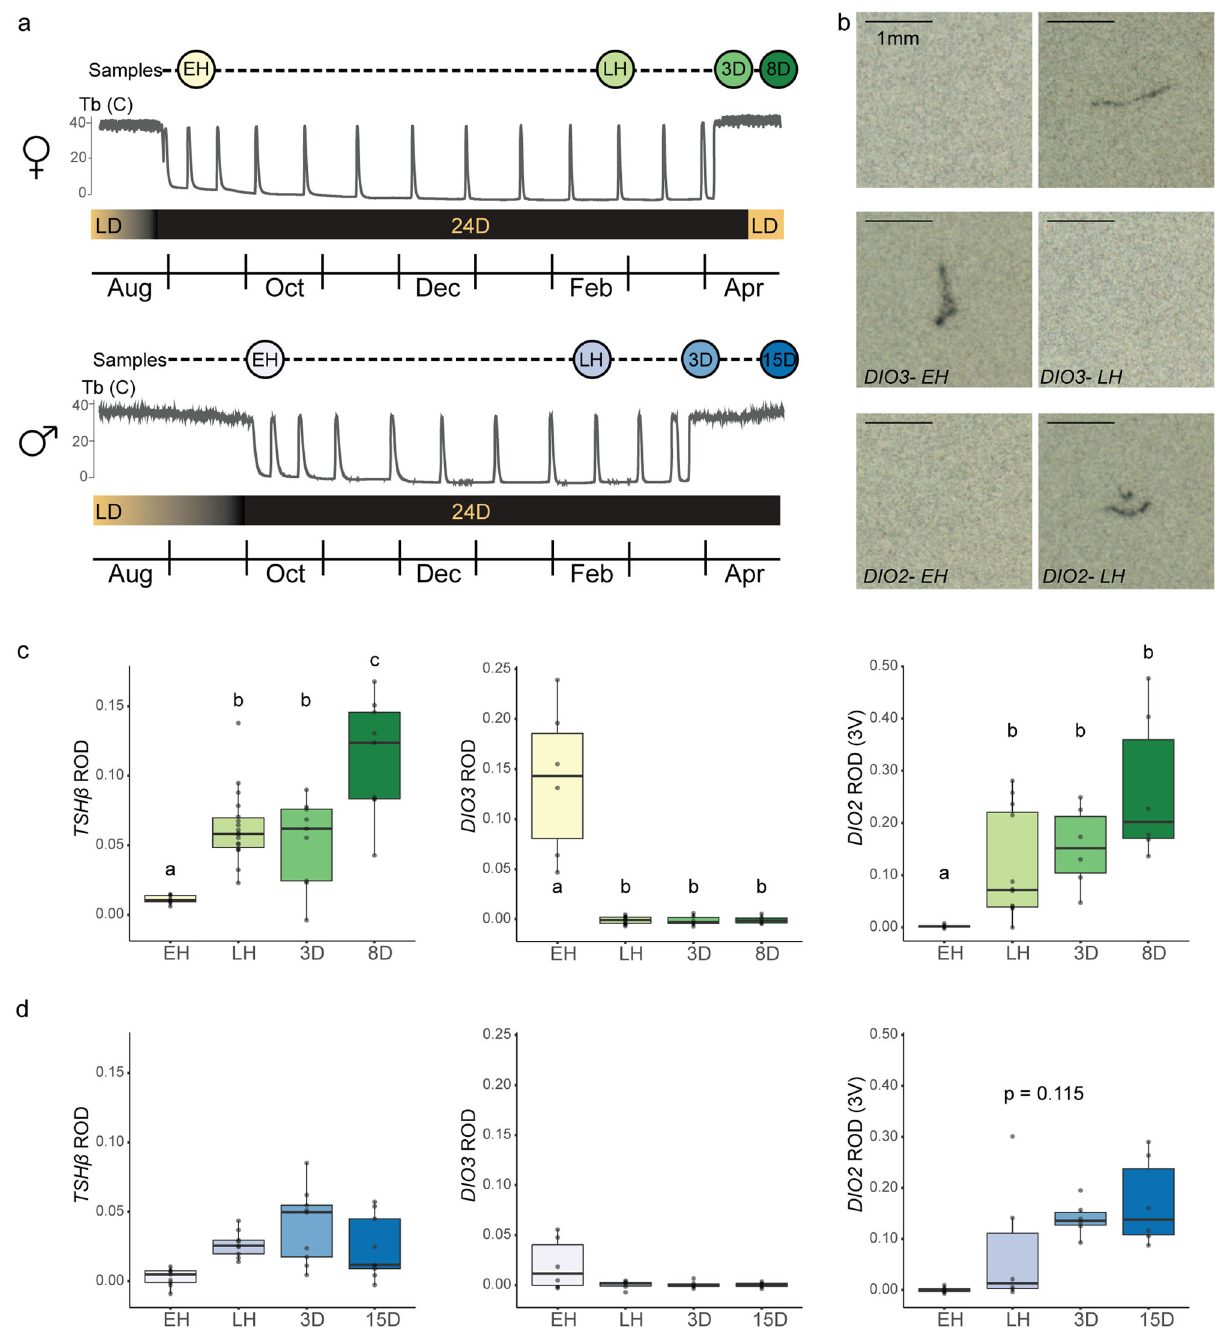
Fig. 1 Activation of the PT/tanycyte (TSH/DIO) axis during hibernation. a Schematic of repeated cross sectional study in female (top) and male (bottom) arctic ground squirrels. The colored circles represent the tissue collection points (EH: early hibernation; LH: late hibernation; 3D: 3 days post- hibernation, 8D: 8 days post-hibernation; 15D: 15 days post-hibernation); all samples were taken from euthermic animals. The thin gray lines represent body temperatures of arctic ground squirrels before, during, and after hibernation; temperature traces are a schematic. The shaded rectangle indicates the photoperiodic regime experienced by study subjects (LD: long-day; 24D: 24 h dark). Panels b – d present data depicting mRNA expression of targets associated with retrograde thyroid hormone signaling between the pars tuberalis and hypothalamus as quanti fi ed by relative optical density (ROD) of radio-labeled probes during in-situ hybridization. b Images of TSH β , DIO2, and DIO3 staining from EH and LH females. Photos selected to represent highest expression observed in group and scale bars are 1 mm. c ROD for females and d males for TSH β in the pars tuberalis and DIO2 and DIO3 along the third ventricle (left to right). Colored shading of boxplots represents sampling groups. Signi fi cantly different pairwise comparisons with linear-mixed effects modeling are indicated by lower-case letters ( p < 0.05). The center line in the box plot represents the median, box boundaries represent the 25th and 75th percentiles, and error bars represent the 25th and 75th percentiles ± 1.5 times the interquartile range. For sample sizes, see methods. See also Supplementary Fig. S1.